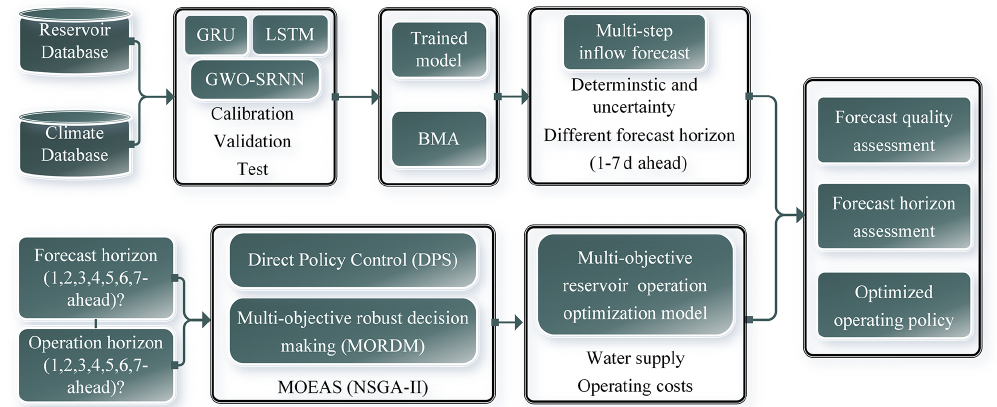
Figure 1. Framework of the AI-based management